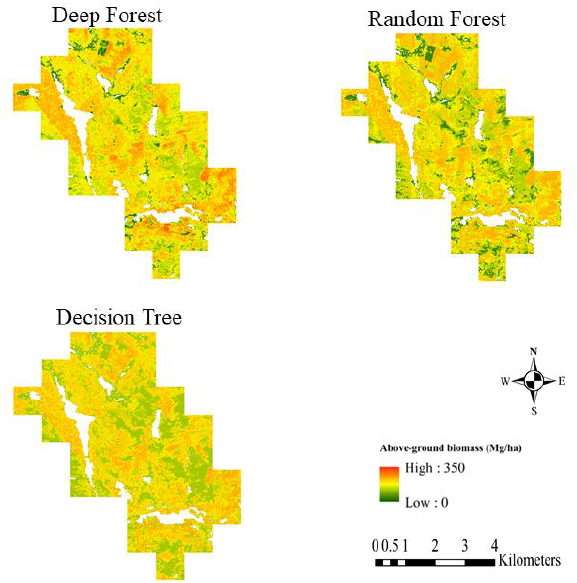
Figure 3 . Above-ground biomass maps of HWF generated using decision tree-based regression models and remote sensing data. The maps are produced based on the combination of LiDAR and Landsat 5 TM data.